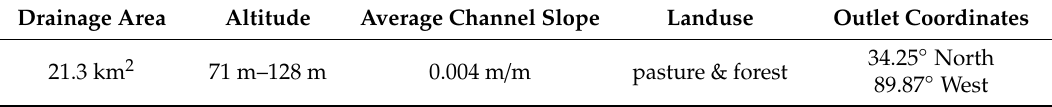
Figure 2. Comparison of different methods of flow-direction determination.